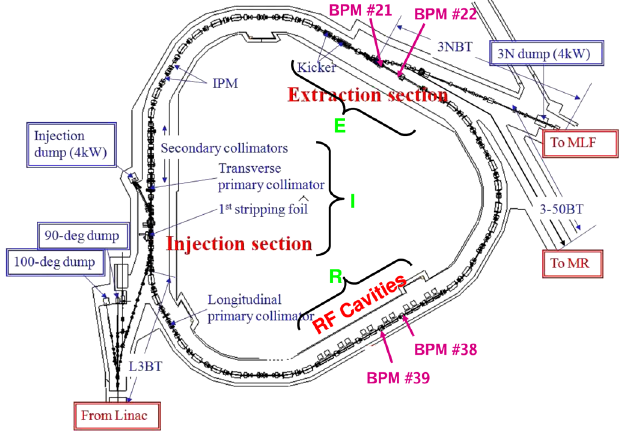
FIG. 1. (Color) Layout of RCS. Three insertions are named as I, E, and R. The injection and transverse primary collimator systems are located in the I insertion, the extraction system in the E insertion, and the rf cavities are in the R insertion. Two pairs of BPMs positioned completely in drift space were used in the single pass mode in the present painting injection study. The first pair is located in the extraction straight section (BPM #21 and #22), while the second pair is located in the rf straight section (BPM #38 and